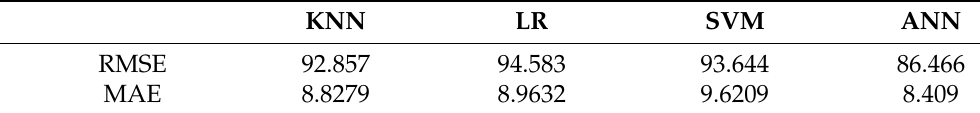
Table 2. Values of error metrics for the validation of the compared methods. Units in Watts